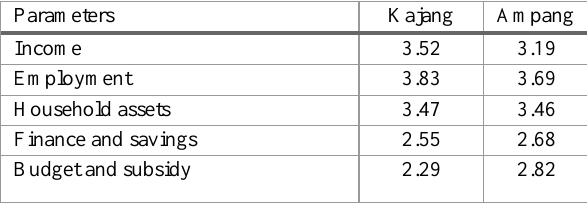
Table 5: Assessment of Economic Component. Source: